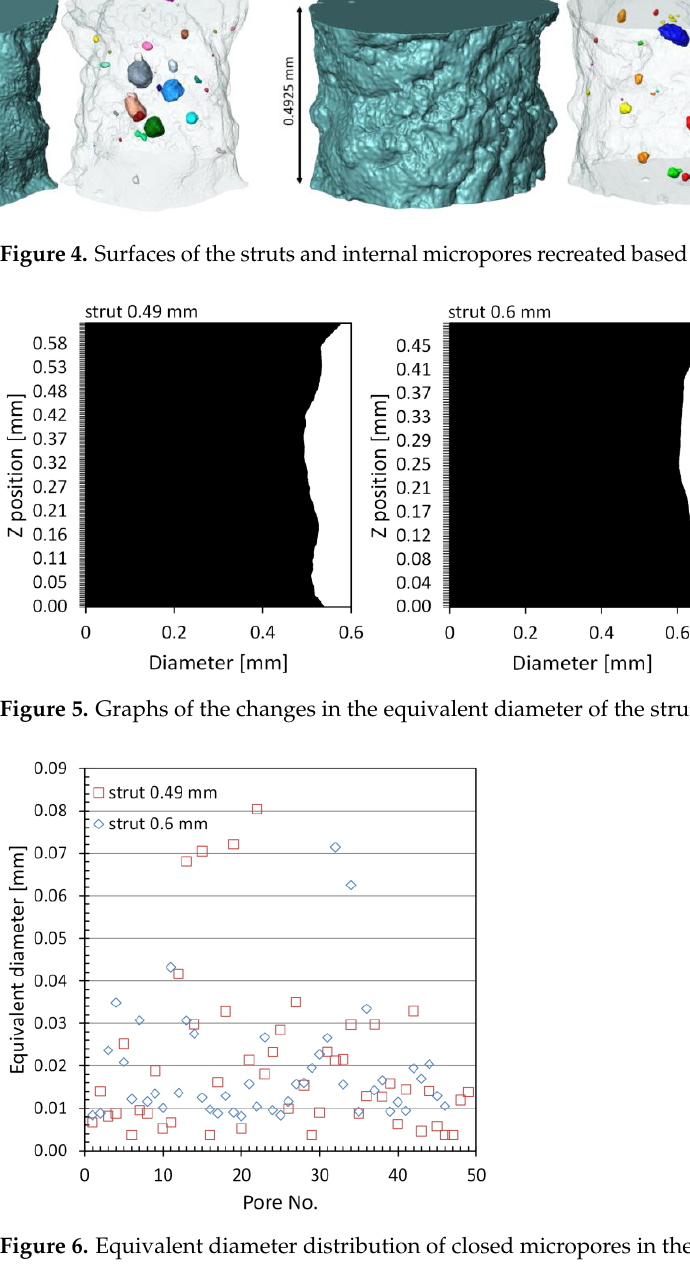
Figure 6. Equivalent diameter distribution of closed micropores in the investigated struts.